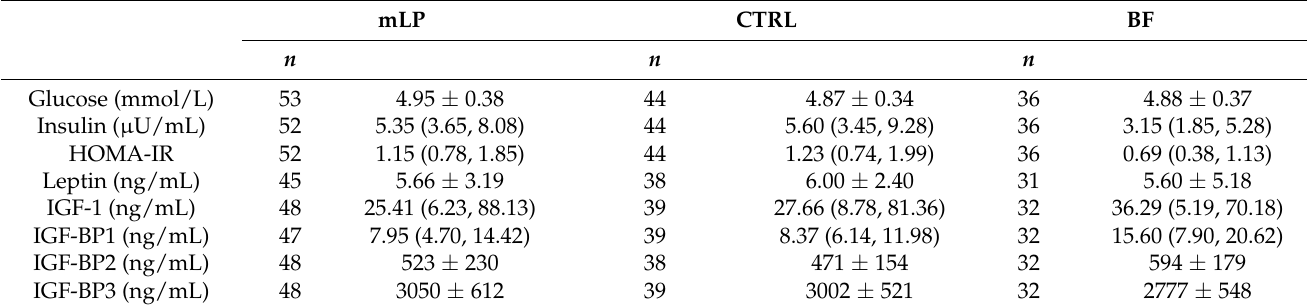
Table 3. Metabolic and hormonal markers at 4 months of